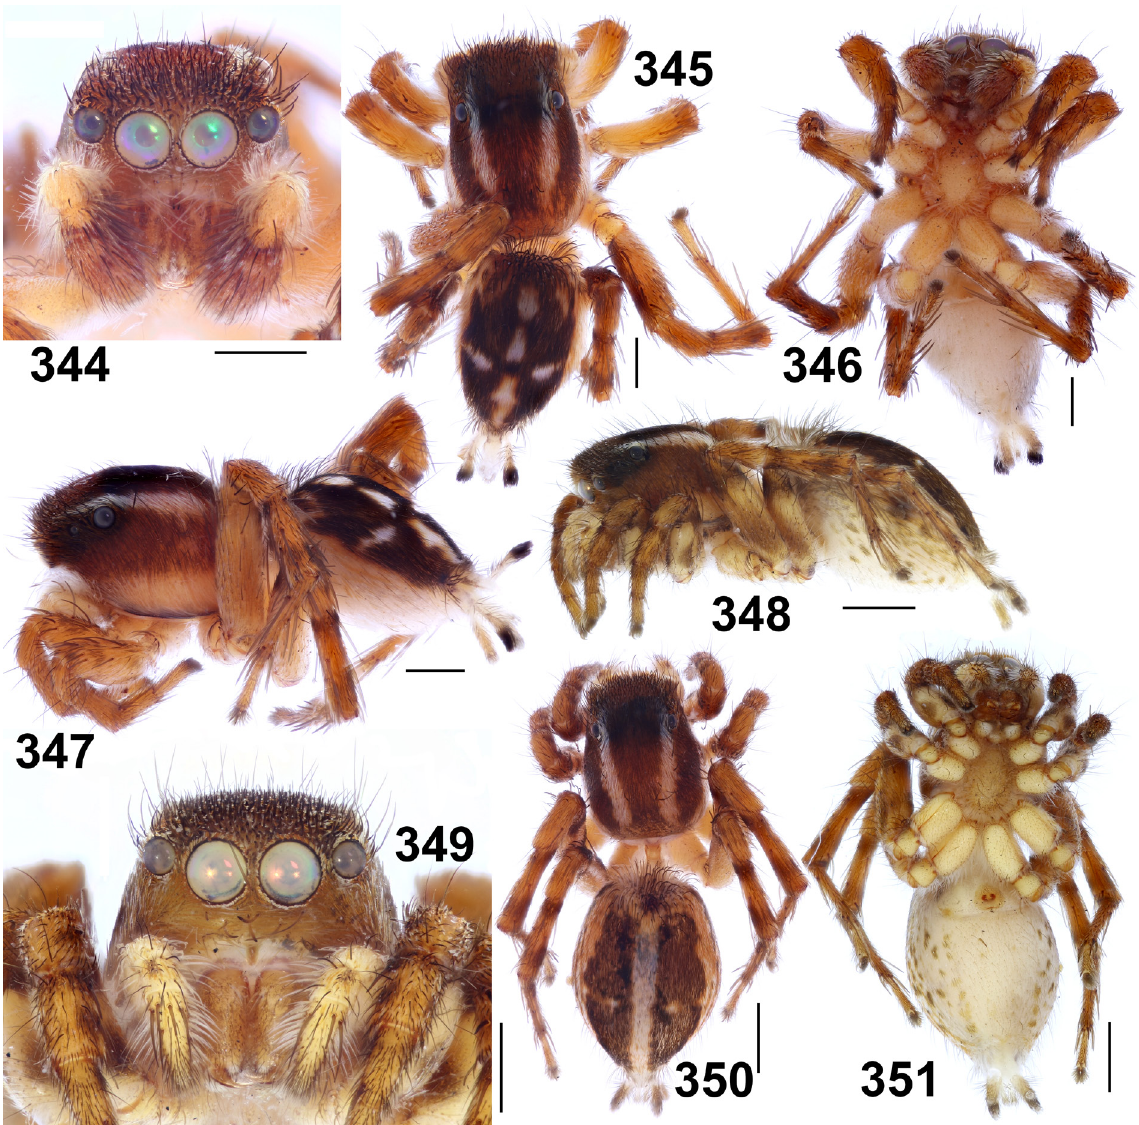
Figs 344–351. Stenaelurillus mirabilis Wesołowska & Russell-Smith, 2000, from Tanzania